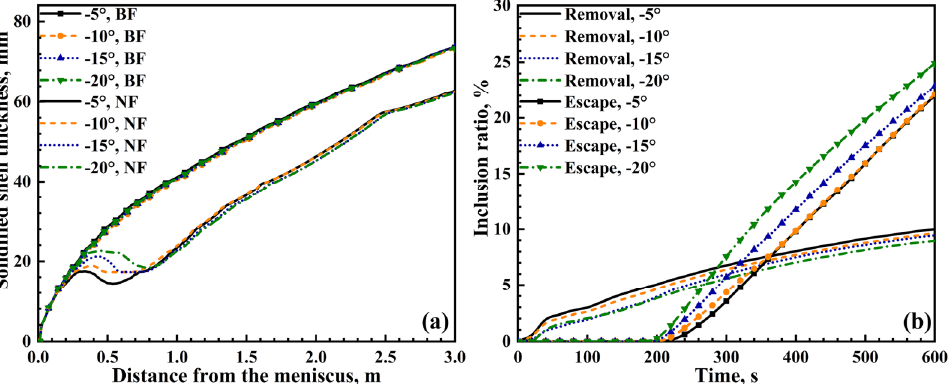
Figure 10. Solidified shell distributions along the casting direction ( a ) and the predicted inclusion ratios of removal and escape ( b ) with different SEN port angles.